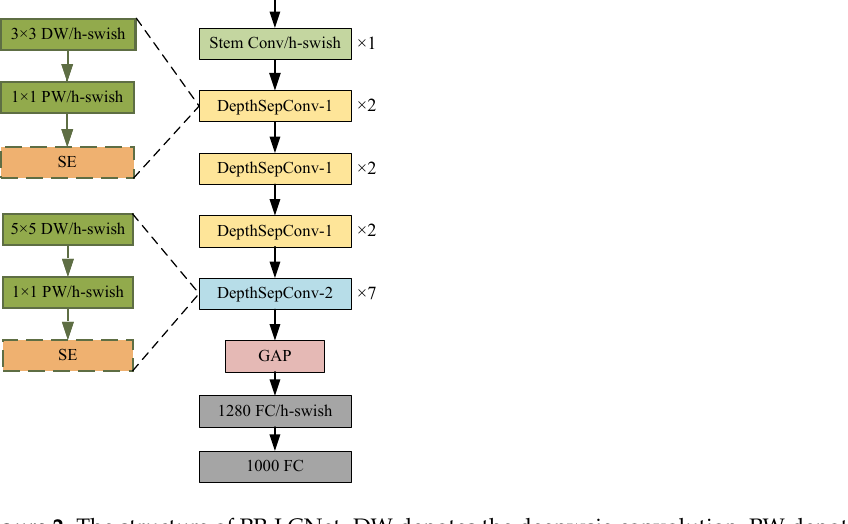
Figure 2. The structure of PP-LCNet. DW denotes the deepwsie convolution, PW denotes the point convolution, Stem denotes the standard convolution, GAP denotes the global average pooling, and FC denotes the fully-connected